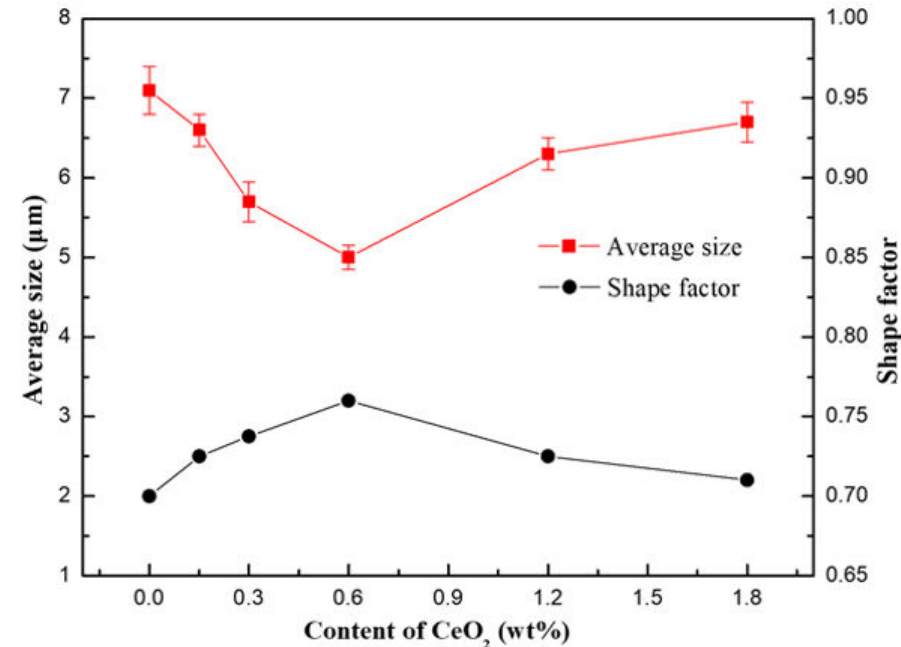
Figure 5. The average diameter and shape factor of Si particles precipitated in the composites with di ff erent CeO 2